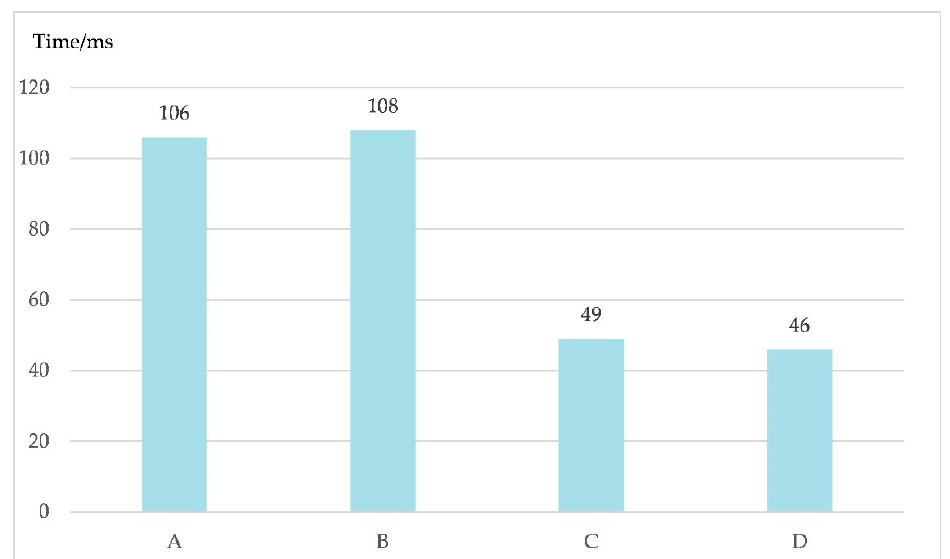
Figure 12. The time spent training each sample when the batch normalization layer was added into different positions. The BN layer was added into the fully connected layer, the output layer, and the two convolution layers, expressed as A. The BN layer was added into the two convolution layers, expressed as B. The BN layer was added into the fully connected layer and the output layer, expressed as C. Finally, the BN layer was not added, expressed as D.